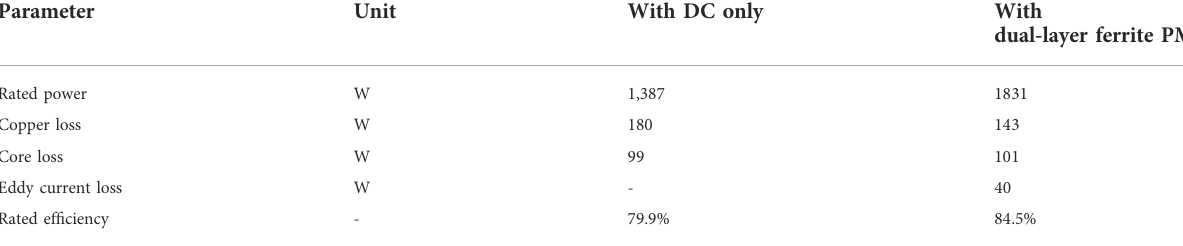
TABLE 4 Power, loss, and ef fi